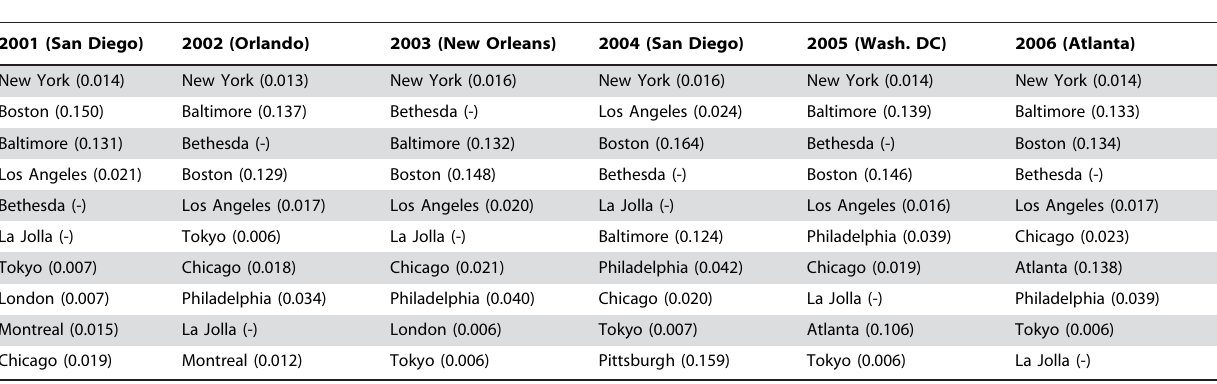
Table 1. Top 10 cities for SFN representation in terms of raw number of abstract authors between 2001 and 2006.